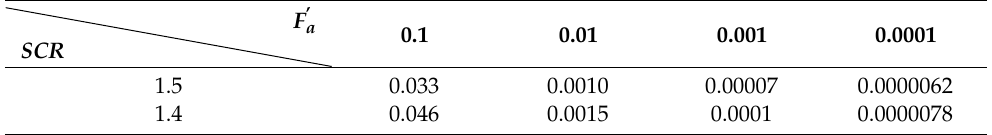
Table 6. F a after target